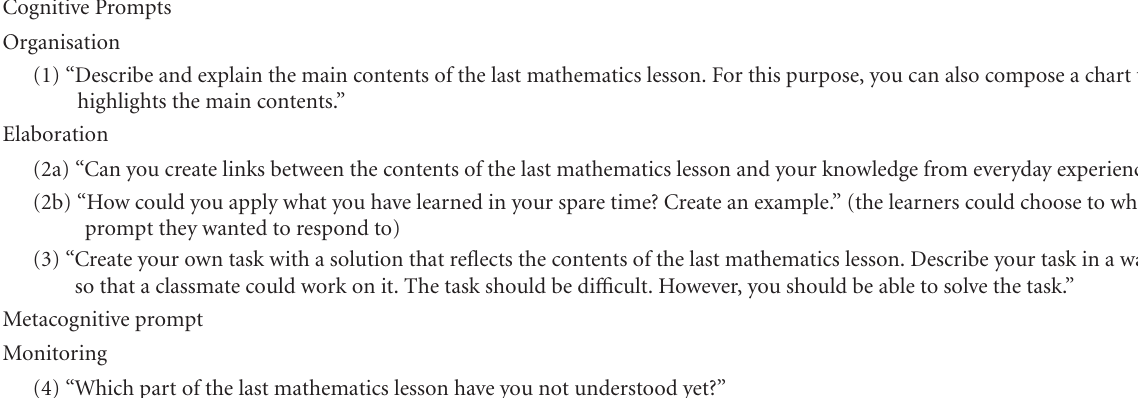
Table 1: Prompts used in this study (translated from